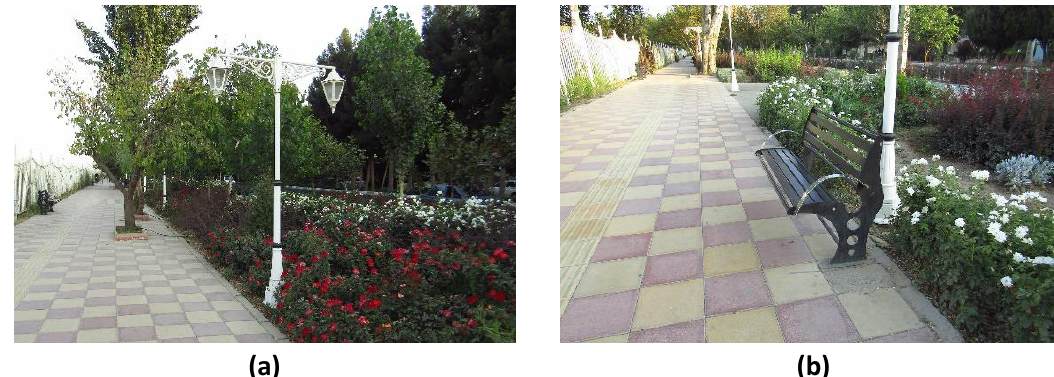
Fig. 10: (a) Two-headed street light, existing in the path, in a good shape; (b) A metal bench that made of unsuitable and uncomfortable materials